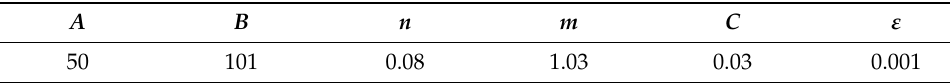
Table 1. Drill bit and bone material properties.